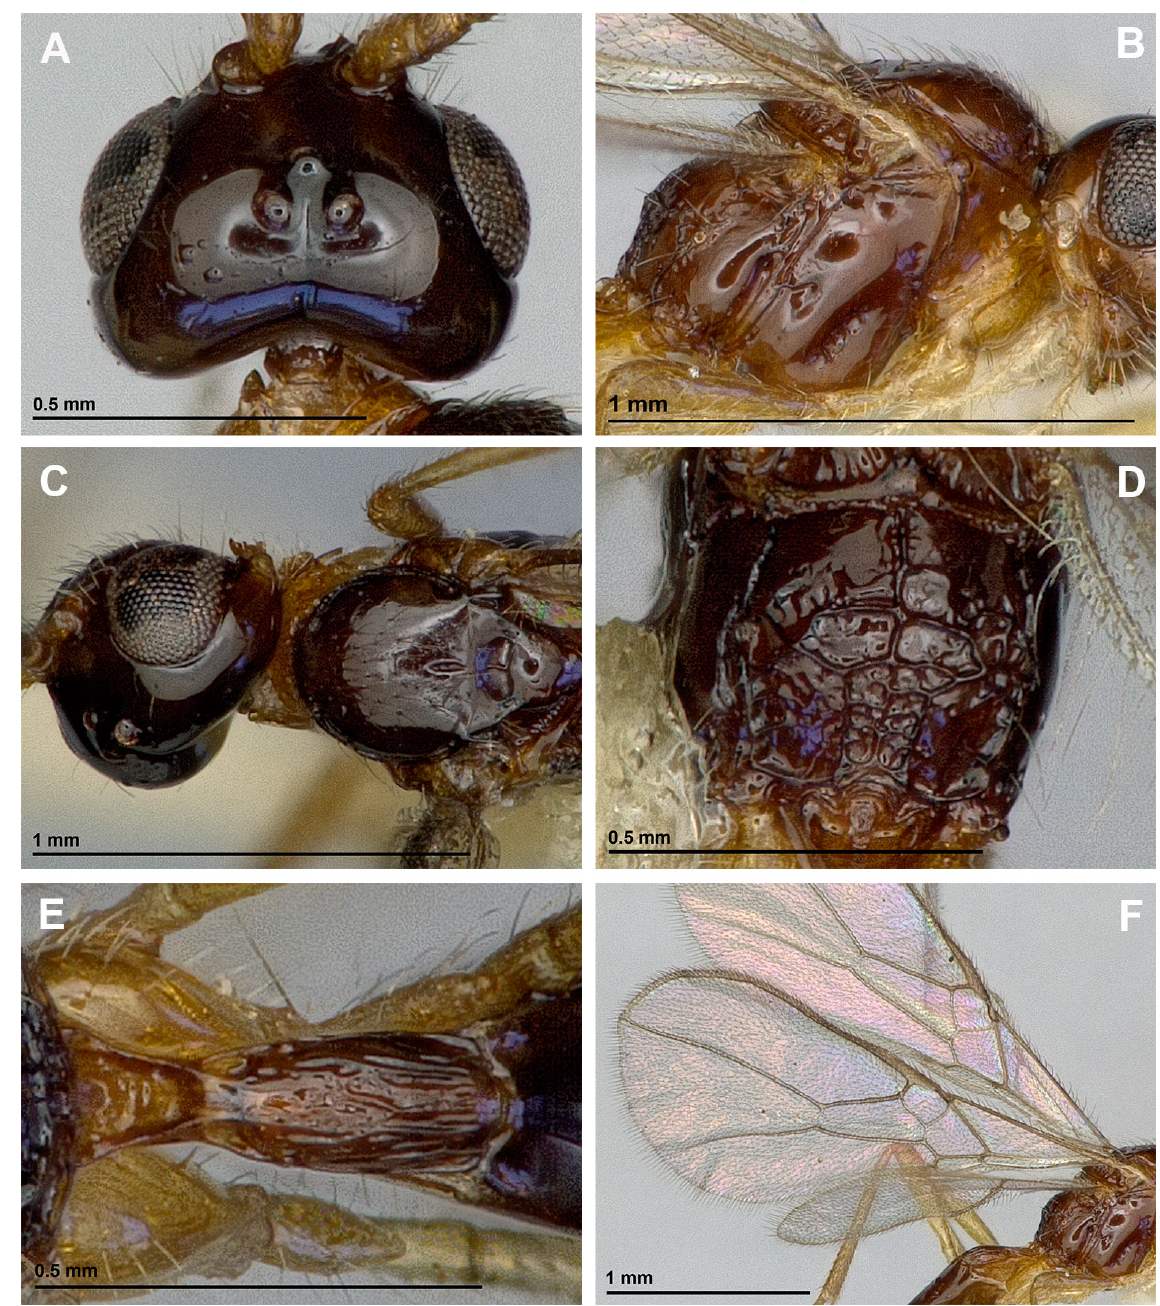
Fig. 2. Dinotrema multiareolatum Peris-Felipo sp. nov. (♀). A . Head, dorsal view. B . Mesosoma, lateral view. C . Head, sublateral view and mesonotum, dorsal view. D . Propodeum, dorsal view. E . First metasomal tergite. F . Fore and hind